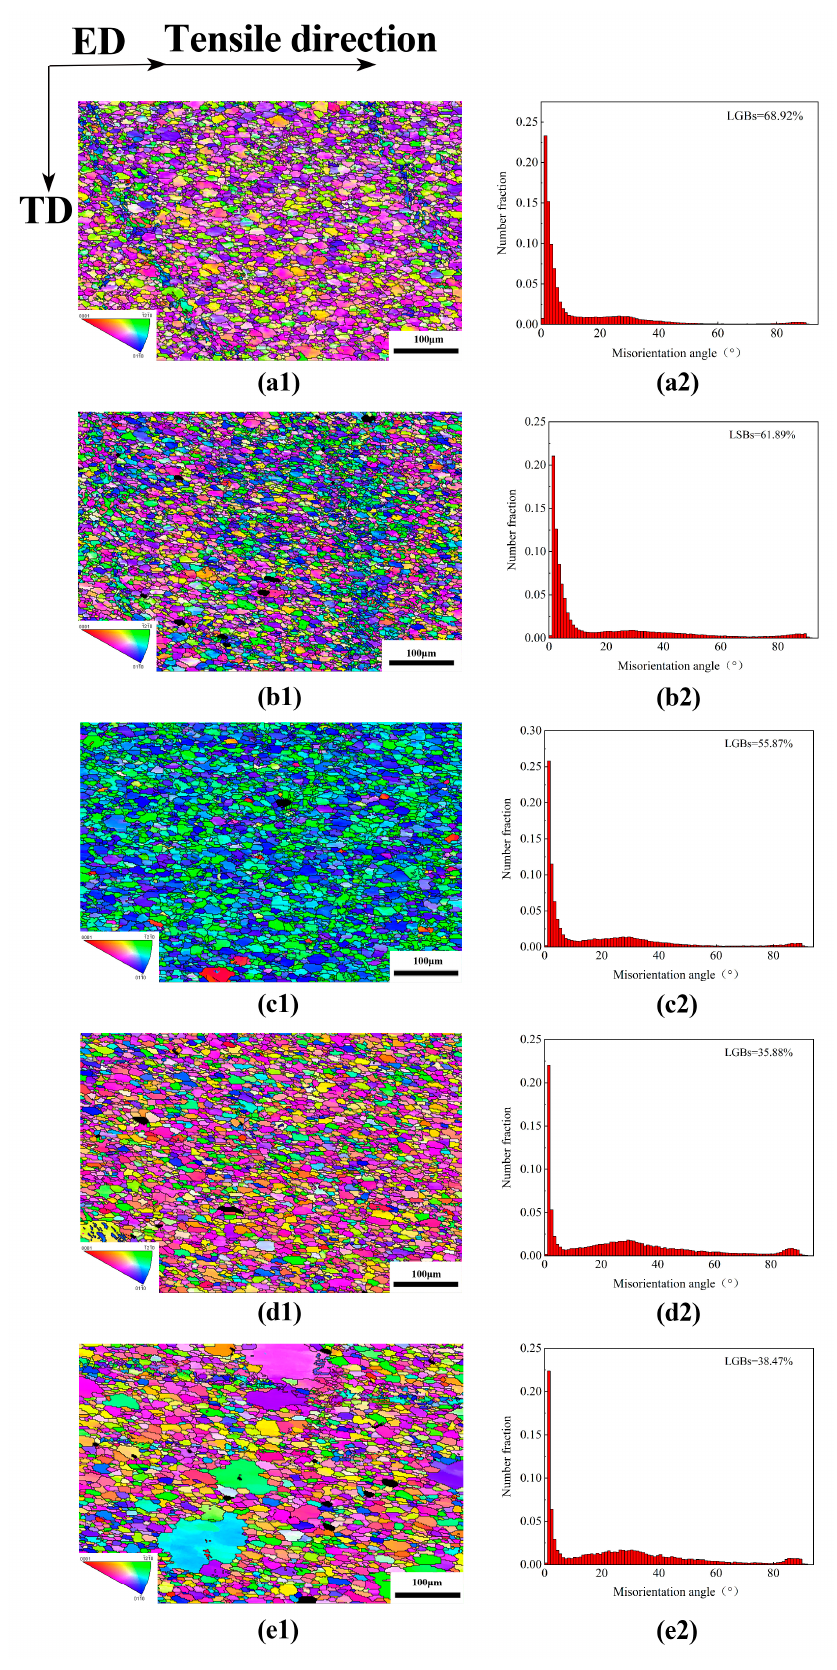
Figure 8. Grain orientation distribution ( a1 – e1 ) and grain boundary orientation difference distribution ( a2 – e2 ) at 300 °C~500 °C.